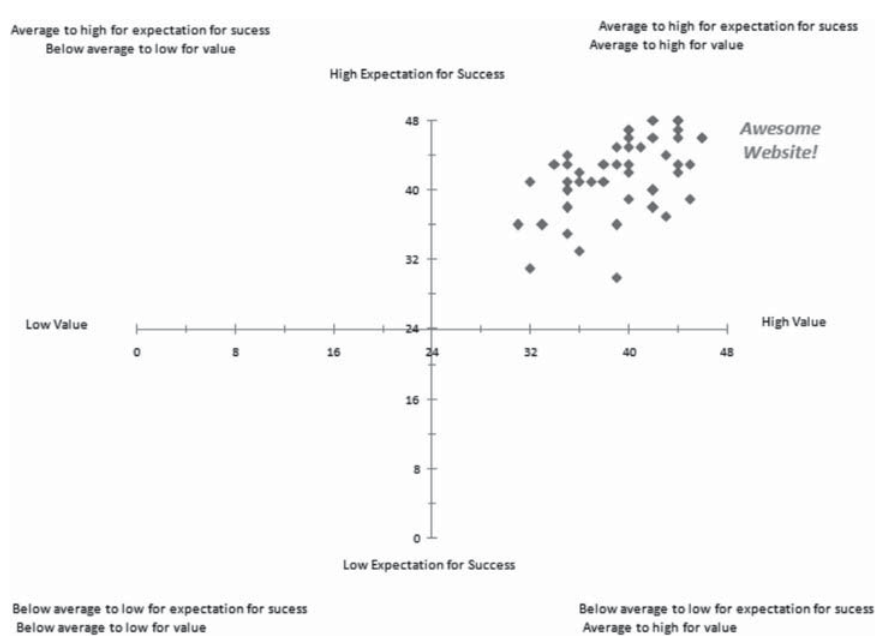
Figure 2- Training program in genetic syndromes evaluation according to the participants of both